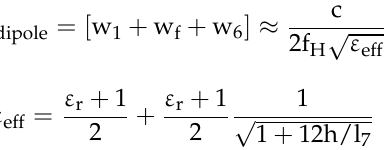
( b ) Figure 7. 2D and 3D radiation patterns of the PLPA at ( a ) 3.5 GHz and ( b ) 5 GHz.